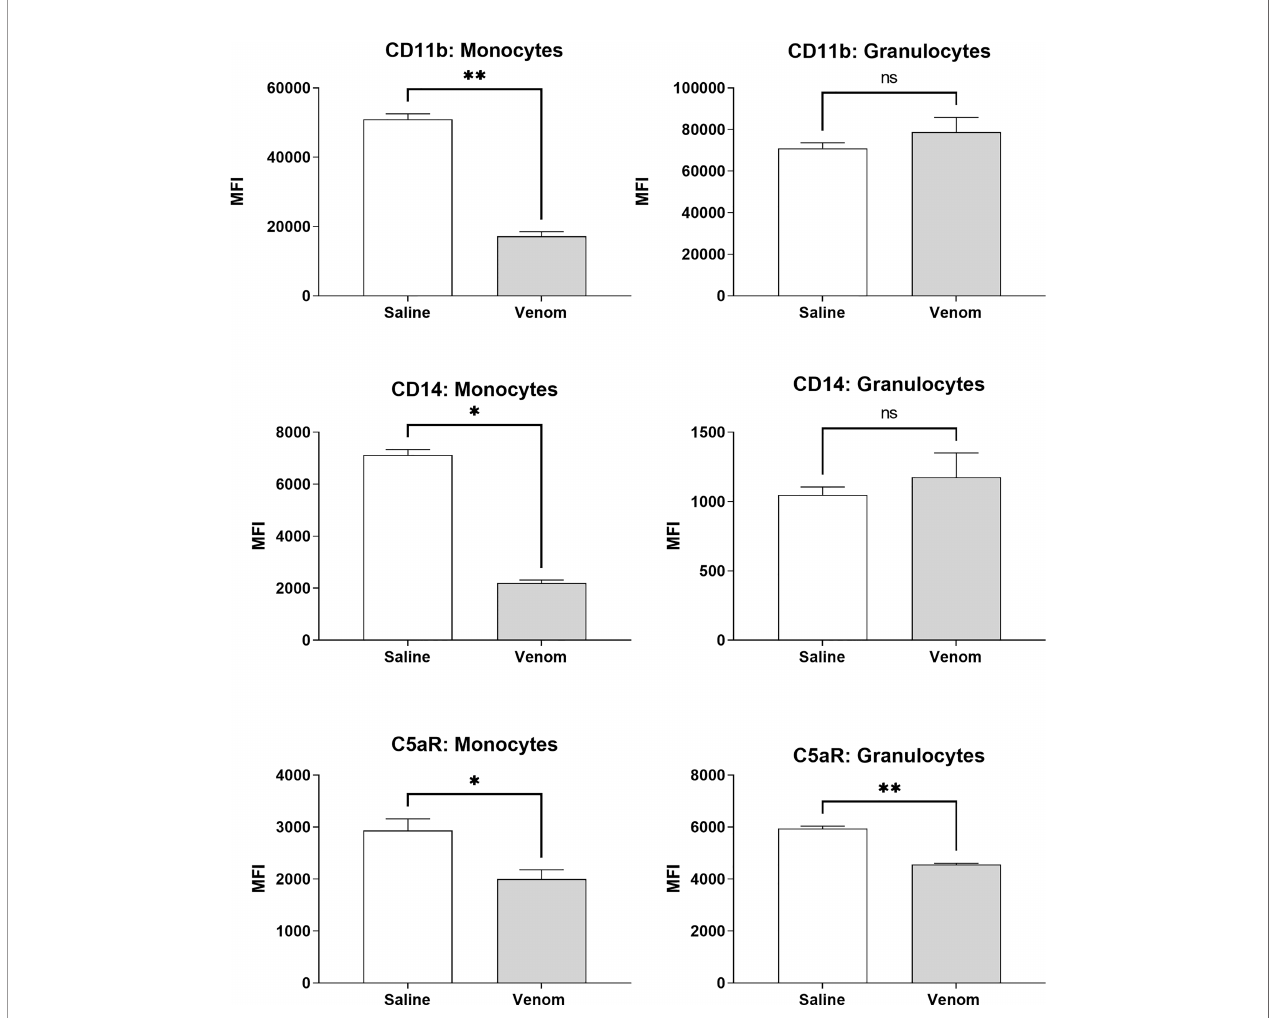
FIGURE 5 | Expression of surface markers in monocytes and granulocytes after treatment with B. jararaca venom. Human blood samples containing GPRP (8 mg/ mL) were treated with B. jararaca venom (50 m g/mL) or sterile saline solution (negative control) for 60 minutes at 37°C. After incubation, cells were analyzed for the expression of CD11b, CD14 and C5aR. The results are expressed as MFI ± SEM of duplicates from three independent experiments. ns, not signi fi cant; * p ≤ 0.05, ** p ≤